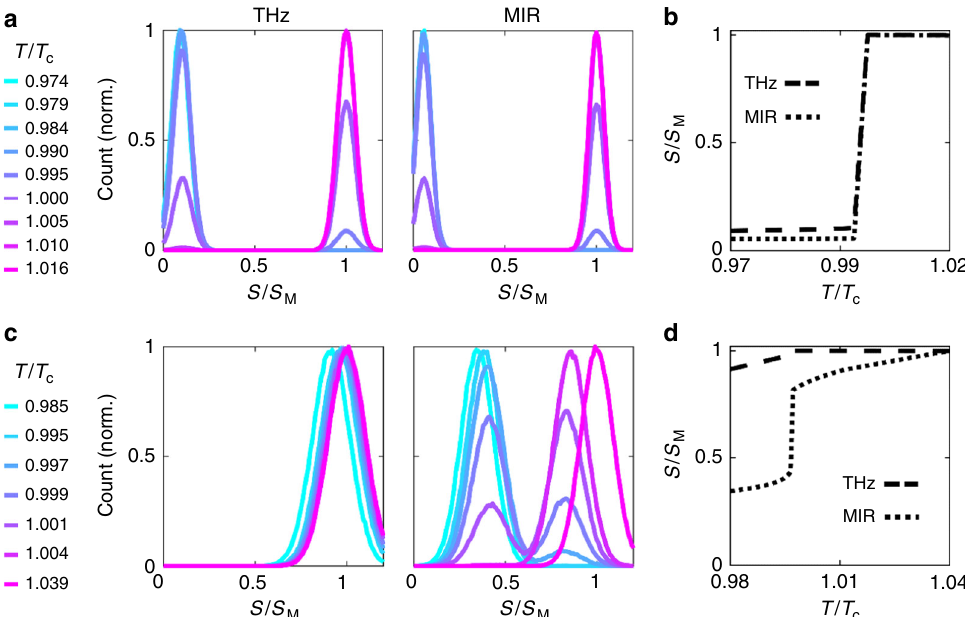
Fig. 5 Histograms of a phase-separated image using near- fi eld signals at different temperatures calculated from the DHM. a The simulated histograms for a THz and MIR image in the case of small t ⊥ / U . The signals are calculated at the frequencies represented by the dashed (THz) and dotted (MIR) vertical lines in Fig. 4c. The temperatures shown are normalized to T c . b Plot of the calculated near- fi eld signal as a function of temperature for small t ⊥ / U at THz (dashed) and MIR (dotted) frequencies. c Same as ( a ), but for large t ⊥ / U . The signals are calculated at the frequencies represented by the dashed (THz) and dotted (MIR) vertical lines in Fig. 4f. d Same as ( b ), but for large t ⊥ /